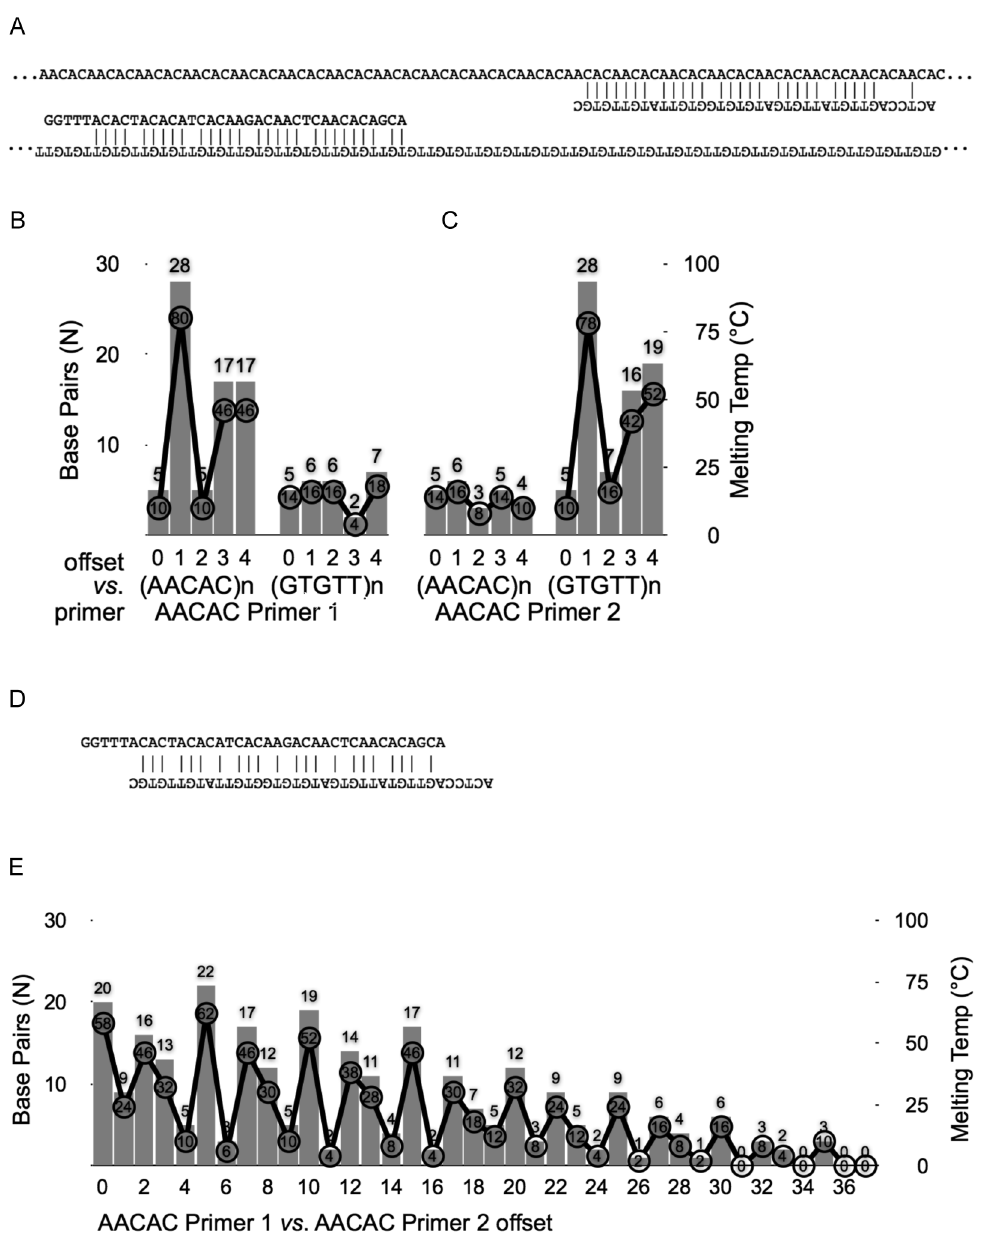
Figure 1. Computational validation of qPCR primers directed at AACAC satellite. ( A ) Representation of homogenous block of AACAC repeat denatured and annealing to AACAC Forward and AACAC Reverse. Vertical lines indicate base pairs. ( B ) AACAC Forward hypothetically annealing to each of the five ‘‘phases’’of AACAC ( i.e. , AACAC, ACACA, CACAA, ACAAC, and CAACA) and it’s reverse-complement. Bars indicate the number of base pairs possible in that phase, and line indicates ad hoc ‘‘melting’’analysis. AACAC Forward has a strong preference for one phase and no affinity for the reverse-complement strand of the repeat. ( C ) as in (B), but with AACAC Reverse. ( D ) Shows the best possible pairing between AACAC Forward and Reverse. ( E ) AACAC Forward and AACAC Reverse pairing with every possible degree of overlap, from completely (at ‘‘0 offset’’) to single 3 9 -most nucleotides pairing (at ‘‘37 offset’’). Bars and lines are as in (B–C). In no case is AACAC Forward/Reverse dimer preferred over annealing to genomic targets (A–C) or the product of previous